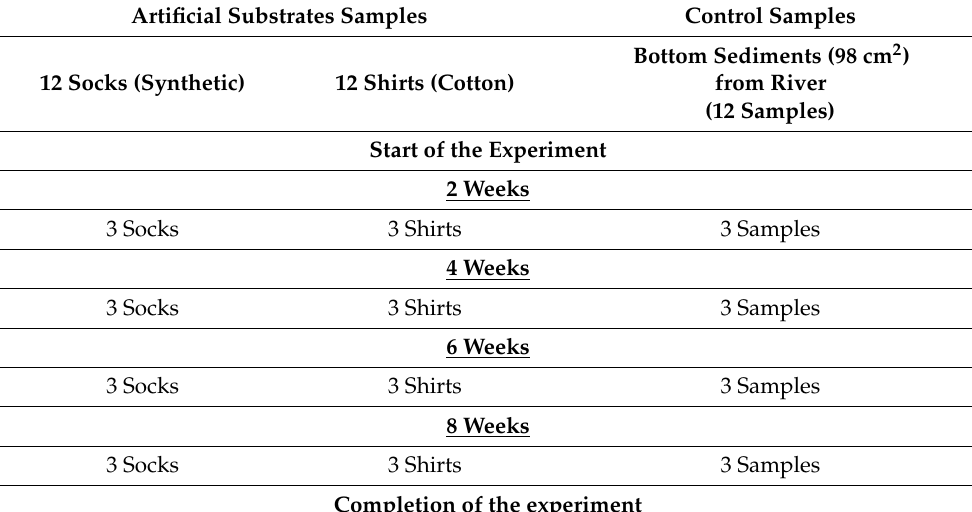
Table 1. Experimental